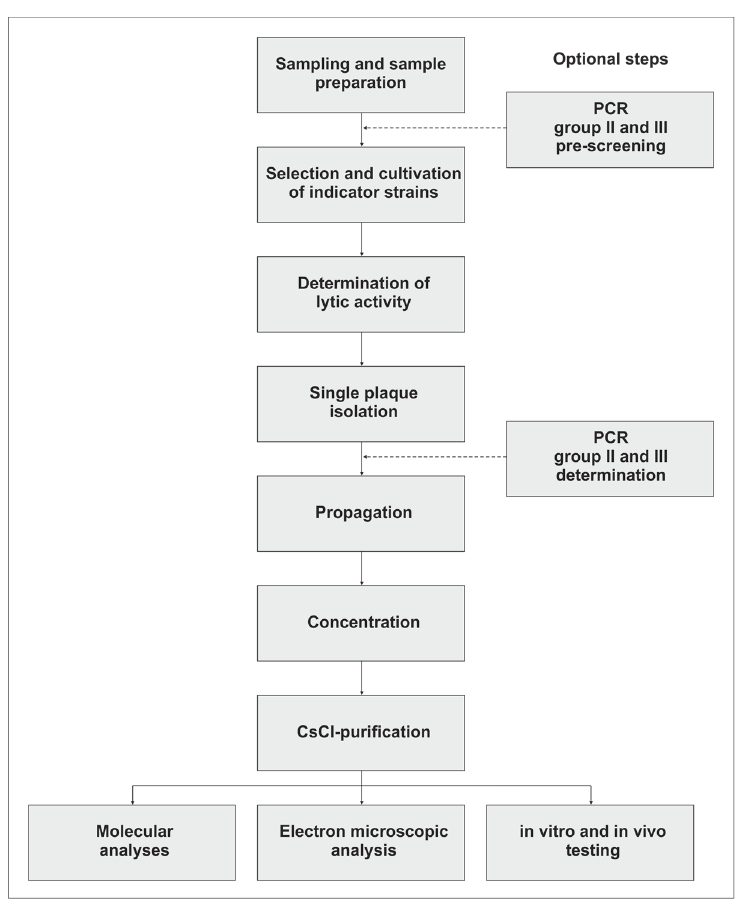
Figure 1. Flowchart of Campylobacter phage isolation, propagation, purification, and analysis. PCR: Polymerase chain reaction.